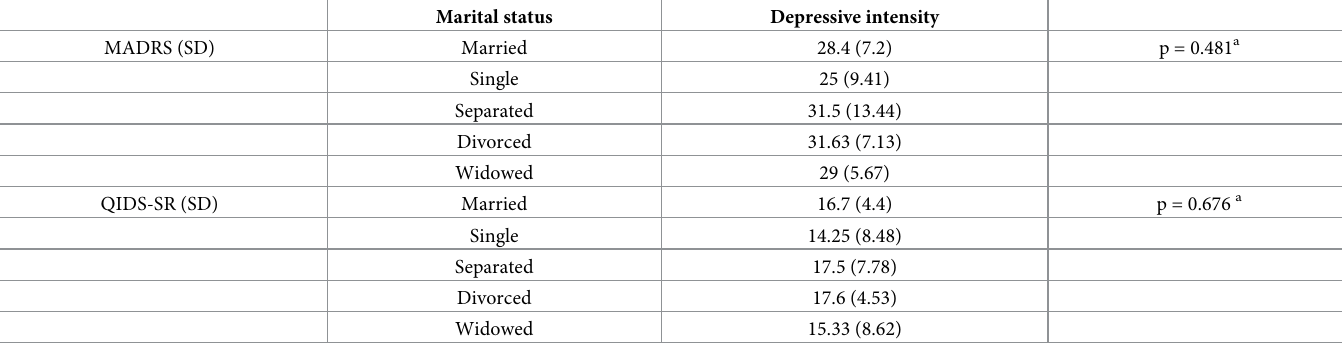
Table 2. Difference in the intensity of depression symptoms on comparing the difference in terms of marital status.